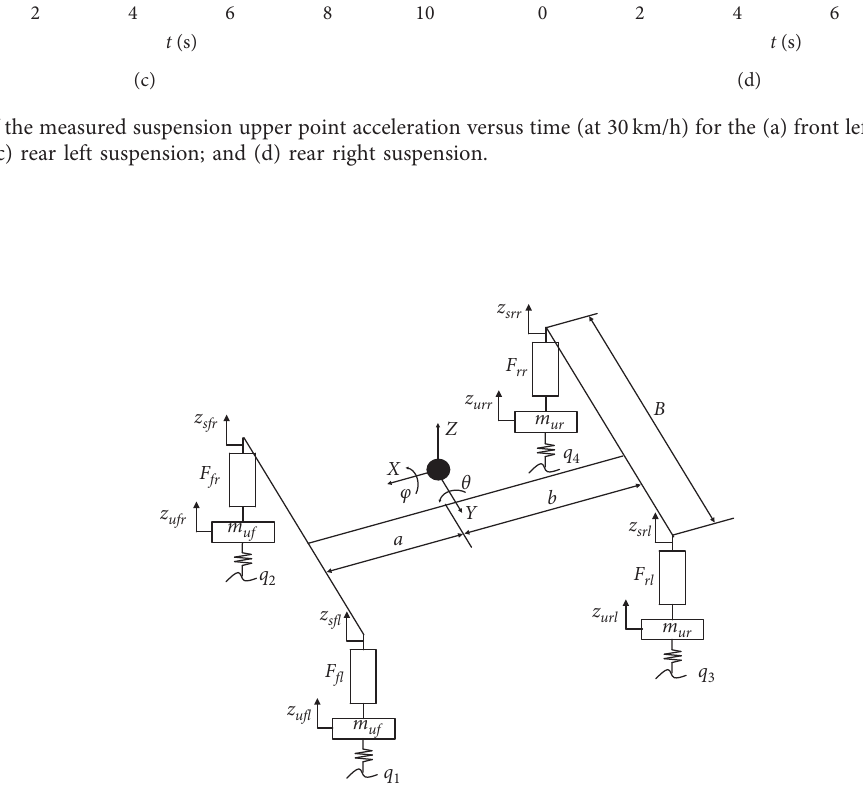
Figure 20: Diagram of the 11-DOF truck model, where q z uij is the deflection of the unsprung mass; deflection of the sprung mass; θ is the pitch angle; and φ is the roll